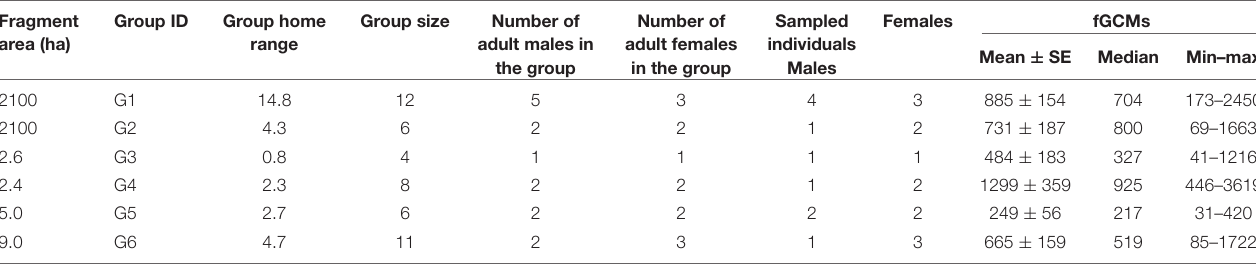
TABLE 2 | Frequency of 15 arboreal taxa used as feeding trees by 6 groups (G1–G6) of black howler monkeys ( Alouatta pigra ).